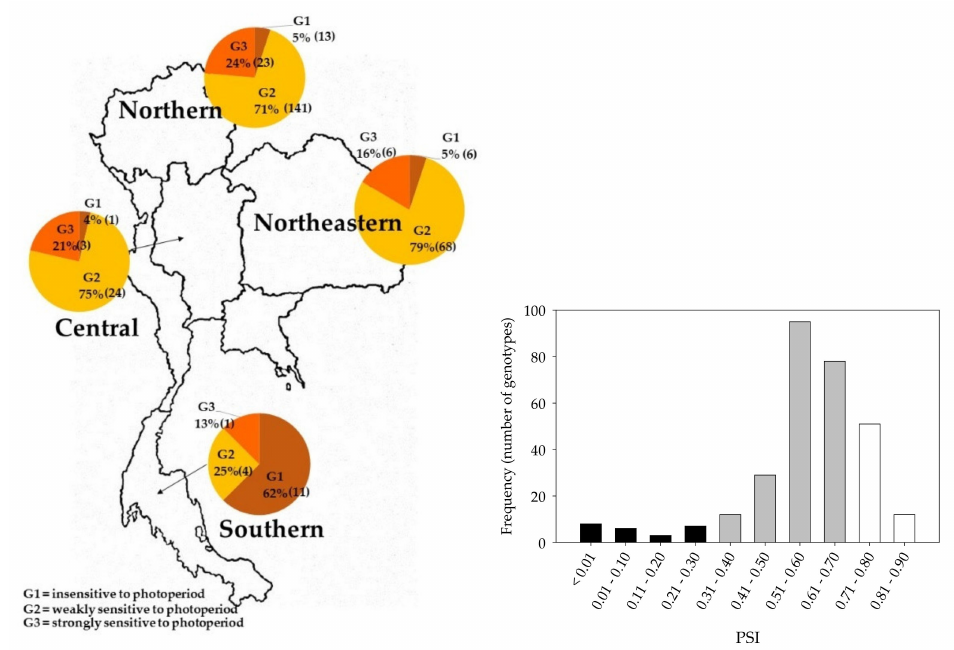
Figure 2. Distribution of indigenous upland rice germplasm in each part of Thailand ( left ), and frequency distribution of photoperiod sensitivity index (PSI) for 301 Thai indigenous upland rice genotypes. The black bar, gray bar, and white bar rice genotypes were insensitive to photoperiod (G1), weakly sensitive to photoperiod (G2), and strongly sensitive to photoperiod (G3), respectively ( right ).